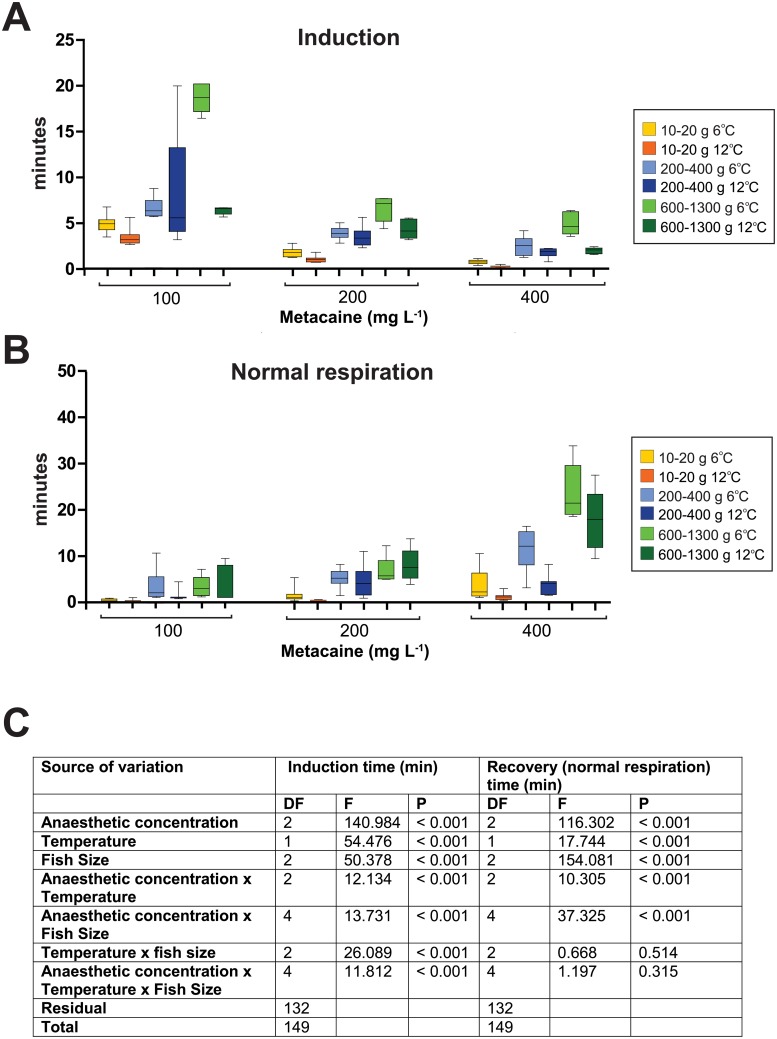
Induction and recovery times during immersion anaesthesia with metacaine.(A) Times for induction for all fish sizes at two temperatures for three different doses of metacaine. (B) Times for recovery (normal respiration). The boxes show average with standard deviation. Yellow boxes = fish 10–20 g at 6°C, orange boxes = fish 10–20 g at 12°C, light blue boxes = fish 200–400 g at 6°C, dark blue boxes = fish 200–400 g at 12°C, light green boxes = fish 600–1300 g at 6°C, dark green boxes = fish 600–1300 g at 12°C. (C) Statistical analyses of effect of Anaesthetic concentrations, temperature and fish size alone or in combination.